Question: Summarize what this figure shows in one sentence.
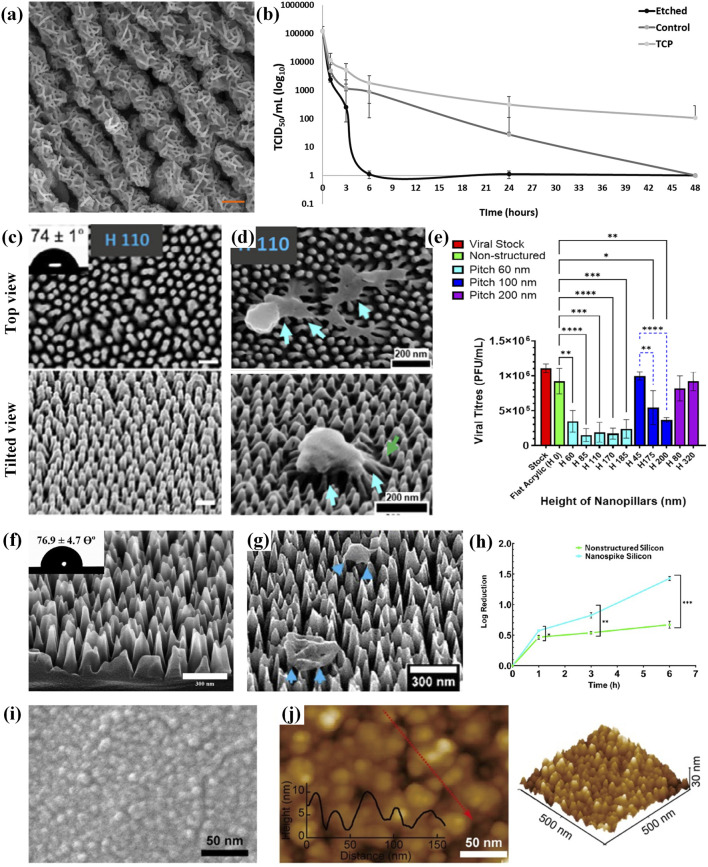
Answer: Fabrication and antiviral performance of nanostructured surfaces. (a,b) Wet-etched nanostructures and their antiviral activity against SARS-CoV-2. Reproduced with permission from ref ( Hasan et al., 2020a ). Copyright 2020 American Chemistry Society. (c–e) Template-assisted nanopillar arrays and corresponding hPIV-3 interaction and inactivation. Reproduced with permission from ref ( Mah et al., 2026 ). Copyright 2026 Wiley-VCH GmbH. (f–h) Reactive ion etched nanospikes and time-dependent antiviral performance. Reproduced with permission from ref ( Mah et al., 2024 ). Copyright 2023 American Chemistry Society. (i,j) RF-sputtered nanocolumnar structures. Reproduced with permission from ref ( Shigetoh et al., 2023 ). Copyright 2023 American Chemistry Society.